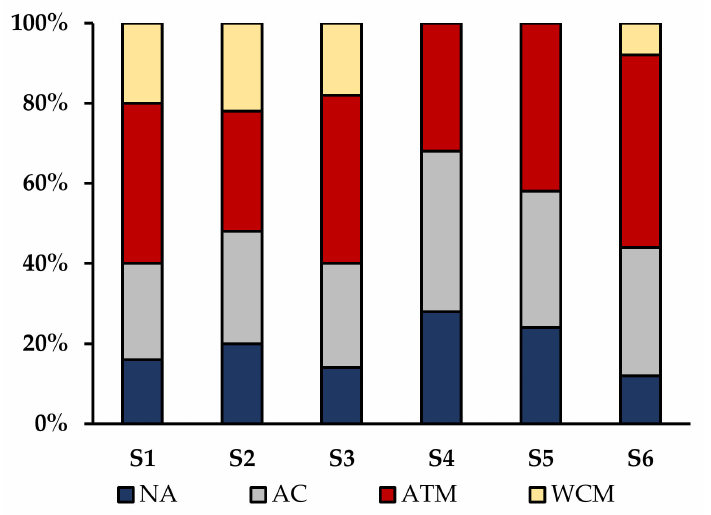
Figure 12. Categorization of awareness towards plastic pollution among local people at differ- ent study areas (NA—not aware, AC—aware but careless, ATM—aware and trying to maintain, CM—well aware and